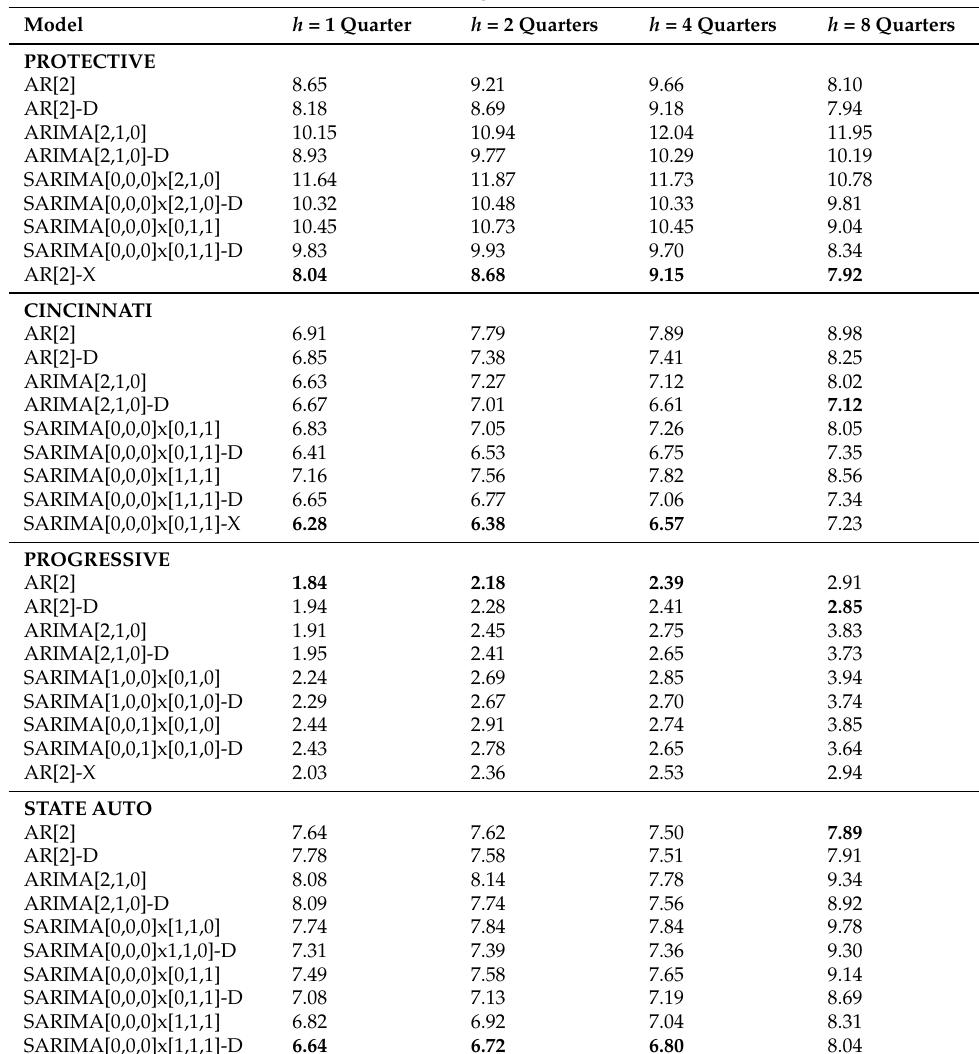
Table 4. Mean absolute errors of forecasts of underwriting ratios for the companies, Protective, Cincinnati, Progressive, and State Auto, forecast horizons h = 1,2,4 and 8 quarters. Best forecasts in bold